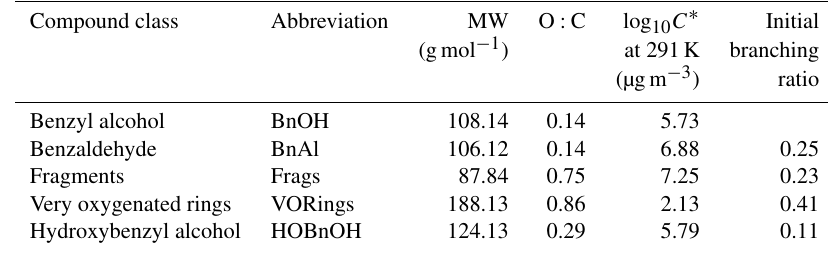
Table C1. Compound class properties for simulating chamber experiments.